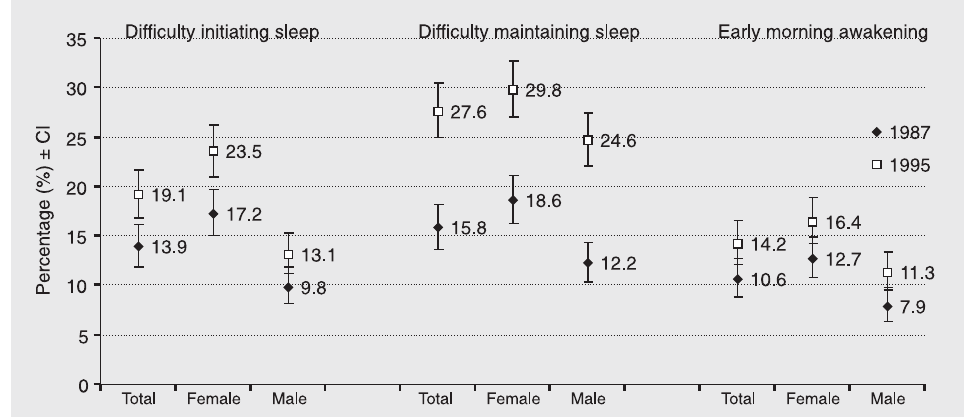
Figure 1. Insomnia complaints by gender in surveys carried out in 1987 and 1995 in the city of São Paulo. Estimates were based on representative samples of 1000 adults per survey. Data are re- ported as percentages ± confi- dence interval (CI) at 95% (Z-